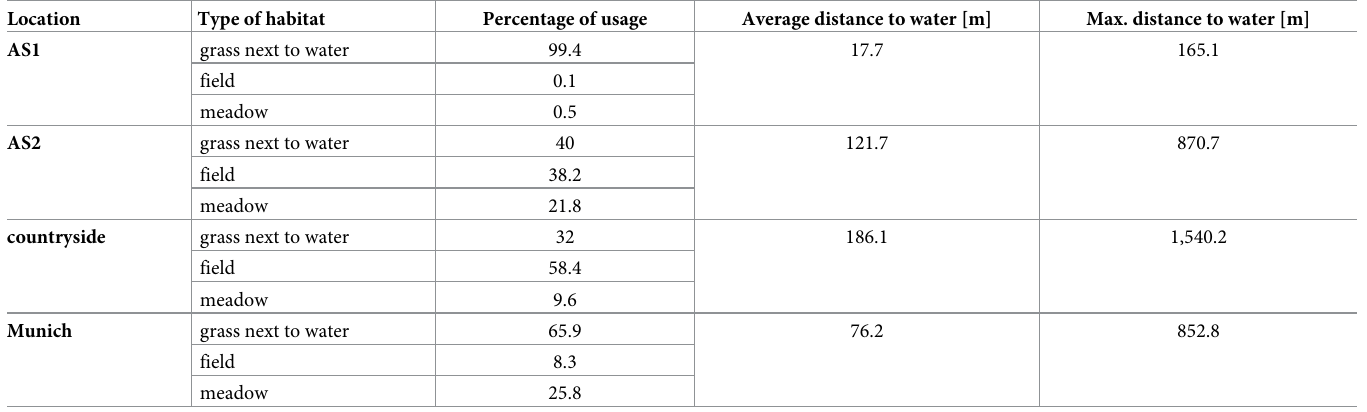
Table 2. Percentage of usage of the different feeding habitats used by greylag geese in the four locations, as well as the average and maximum distances geese fed from the water.